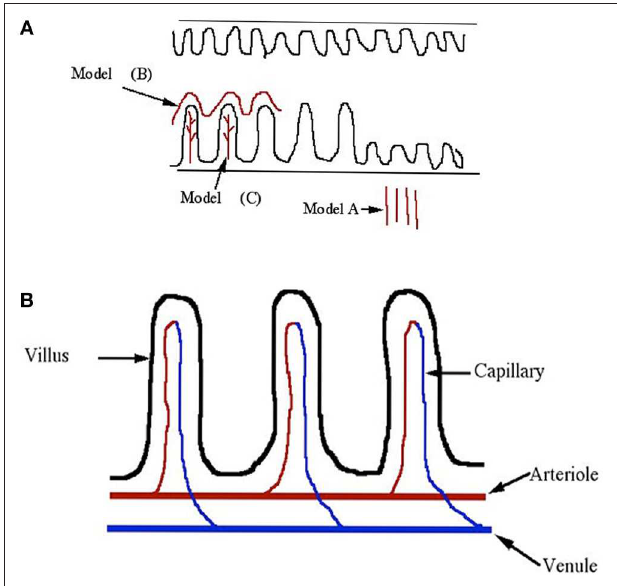
FIGURE 5 | (A) Student models of capillaries in the small intestine. (B) Target model for